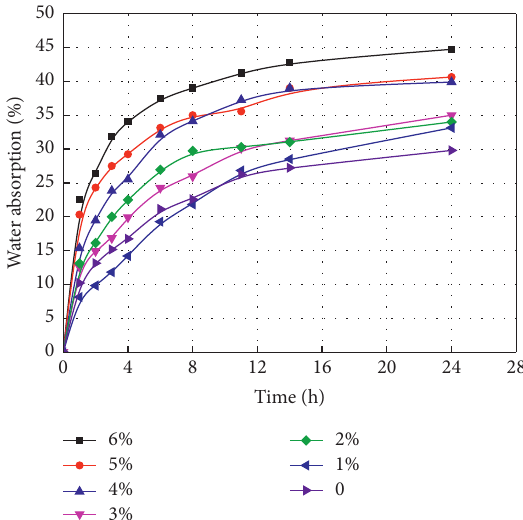
Figure 19: Water absorption of foamed concrete under different diatomite